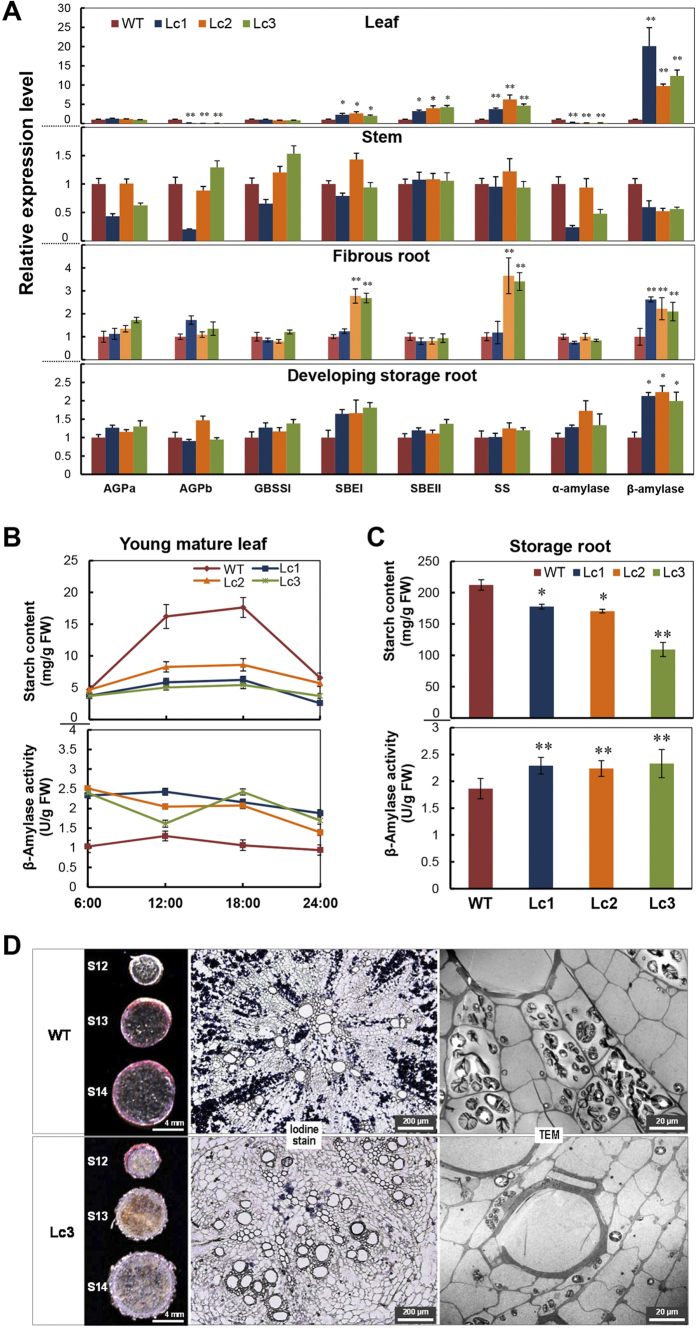
Starch metabolic gene expression profile, β-amylase activity and starch status in young mature leaves, storage roots of wild-type and Lc transgenic sweet potato.(A) Expression levels of the genes involved in starch biosynthesis (AGPa, AGPb, GBSSI, SBEI, SBEII, and SS) and starch degradation (α-amylase and β-amylase) in the leaf, stem and developing storage root (S16) of 2-month-old plants. WT, wild type; Lc1–3, independent Lc transgenic lines; AGPa, ADP-glucose pyrophosphorylase alpha subunit; AGPb, ADP-glucose pyrophosphorylase beta subunit; GBSSI, granule-bound starch synthase 1; SBEI, starch branching enzyme I; SBEII, starch branching enzyme II; SS, soluble starch synthase. (B) Starch content and β-amylase activity in response to diurnal rhythms in mature leaves. (C) Starch content in mature storage roots (S20) of field-grown plants and β-amylase activity of developing storage roots (S16). (D) Dark blue starch granules on sections of early developing storage roots (S12) of 2-month-old plants as determined using Lugol’s solution and TEM observation. Error bars represent the SE of three independent replicates. The asterisks indicate a significant difference compared to the WT at *P < 0.05 or **P < 0.01 (t-test).